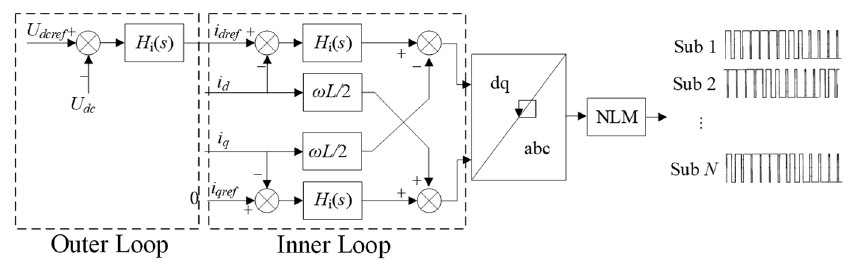
Figure 3. Control block diagram of MMC.